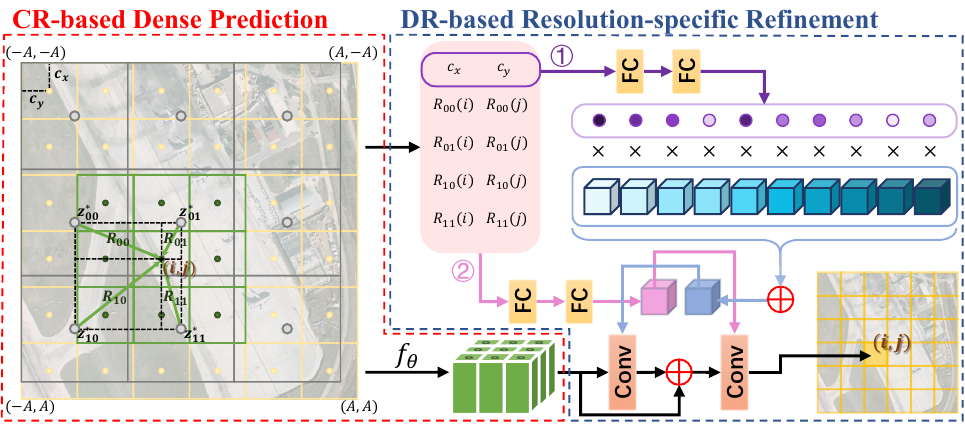
Figure 3. The structure of CDCR. CDCR consists of two parts: a CR-based dense prediction and a DR-based resolution-specific refinement. In the first part, we derive a set of 3 × 3 predictions centered at coordinate ( i , j ) through the dense prediction f θ . In the second part, we adjust the predictions for the given resolution by means of two branches: Branch 1 (designated by symbol (cid:172) ) pre-modulates the features based on scale information, while Branch 2 (designated by symbol (cid:173) ) further embeds the predicted pixels into the specified resolution by leveraging the coordinate offsets and modulated